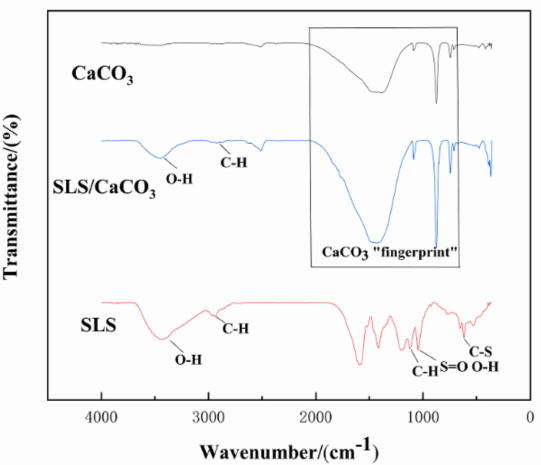
Figure 6. Attenuated total reflection-Fourier-transform infrared spectroscopy (ATR-FTIR) spectra of CaCO 3 , SLS, and SLS-modified CaCO